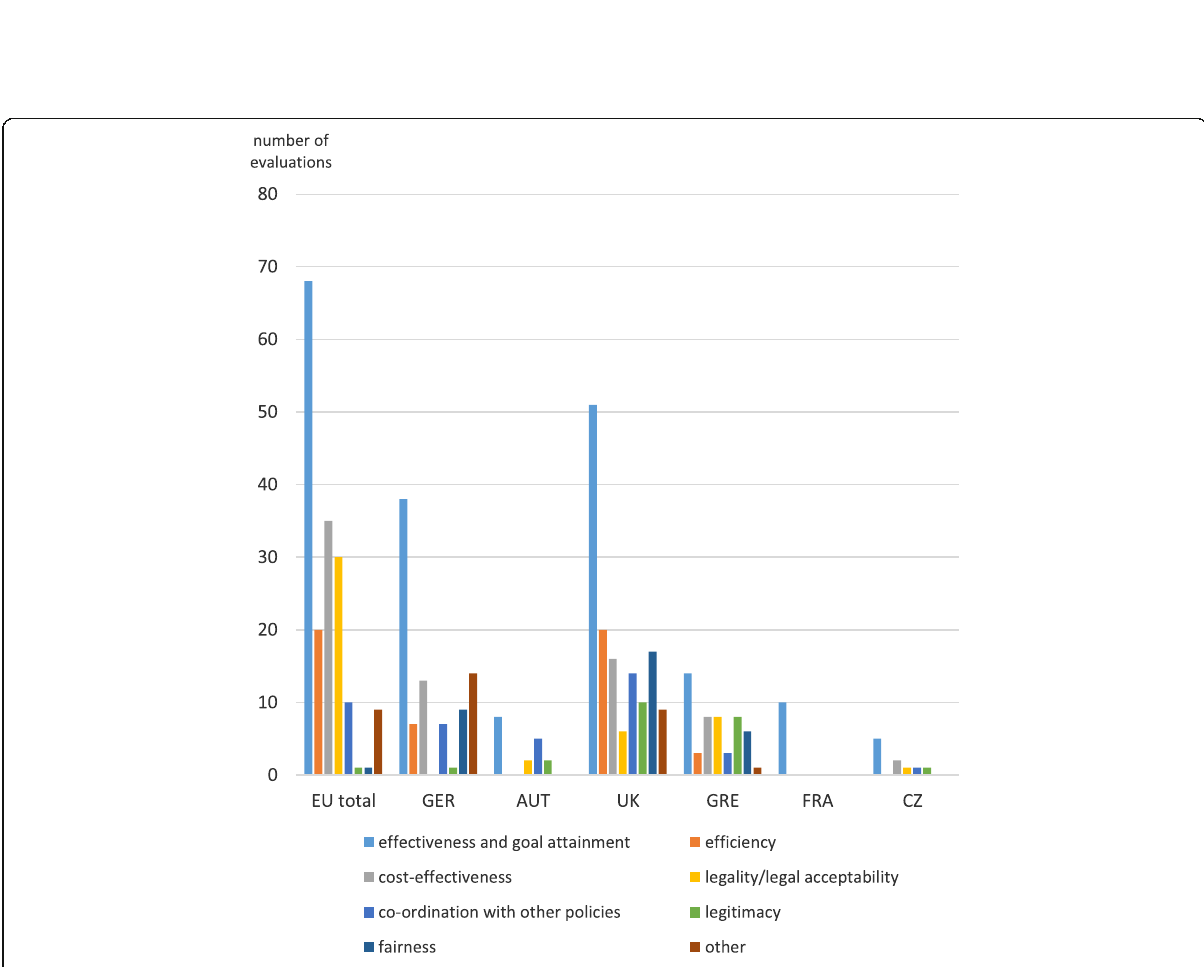
Fig. 9 Evaluation criteria by